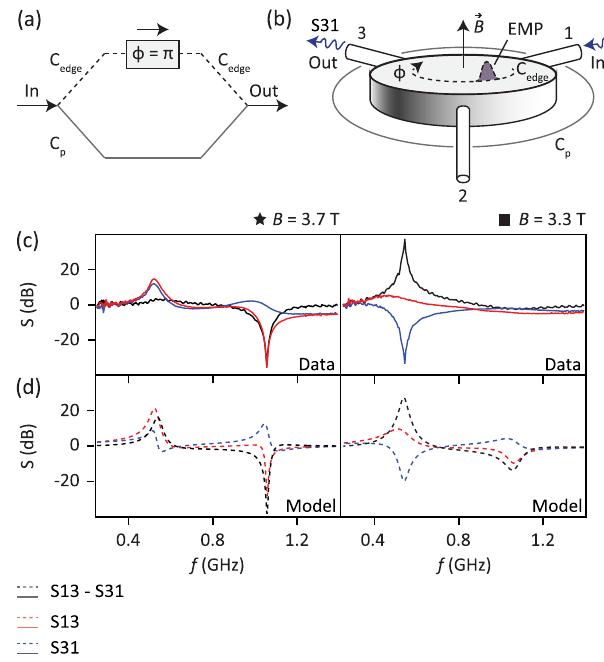
FIG. 4. Comparison of data and model. (a,b) Proposed inter- ferometric mechanism underlying the operation of the quantum Hall circulator, with a slow plasmonic path, via C , and a direct edge capacitive path, via C . A nonreciprocal response between ports p is produced for frequencies where the two paths are out of phase by ϕ ¼ π in the forward direction and ϕ ¼ 2 π in the reverse direction. (c,d) Comparison of a simple model that captures this physics (bottom graphs), with experimental data (top graphs), at two different magnetic fields indicated by the symbols [with respect to Fig. 3(c)]. The model is described in detail in the Appendix, with parameters set to values Z 0 ¼ 50 Ω , ¼ 315 fF, C ¼ 127 fF, R ¼ 5000 Ω , with R ¼ 80 Ω C p xy edge in the center of an EMP resonance (star symbol) and R ¼ 350 Ω off resonance (square symbol). Note that the impedance- ¼ 25 k Ω towards a few k Ω , matching network transforms R xy consistent with the value used in the